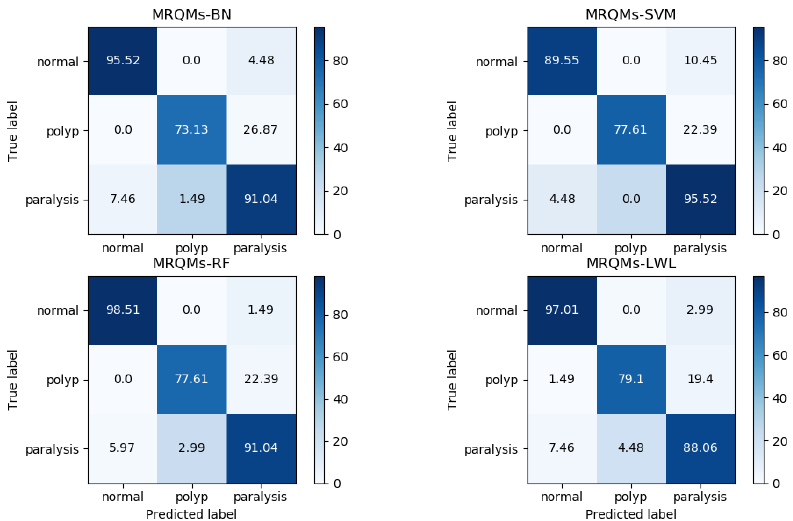
Figure 6. The confusion matrix for pathological voice multiclass classification with 10-fold cross validation. Table 7. Multiclass classification of MRQMs.